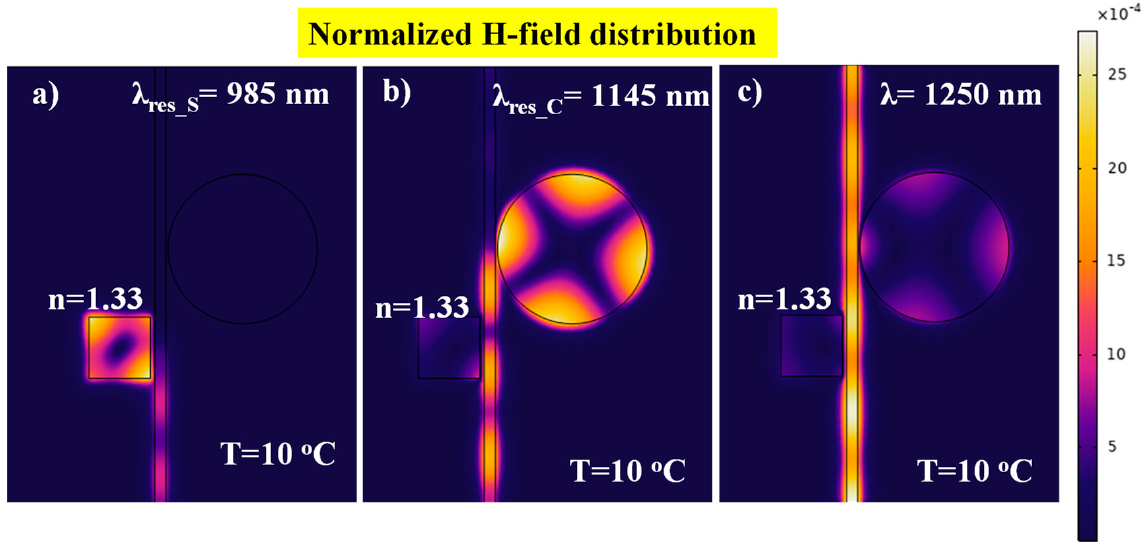
Figure 8. Normalized H-field distribution at ( a ) λ res_S = 985 nm; ( b ) λ res_S = 1145 nm; and ( c ) non-resonant mode, λ = 1250 nm. The geometric parameters used in this analysis are W = 50 nm, L = 280 nm, R = 340 nm, g = 20 nm, and g 1 = 10 nm.